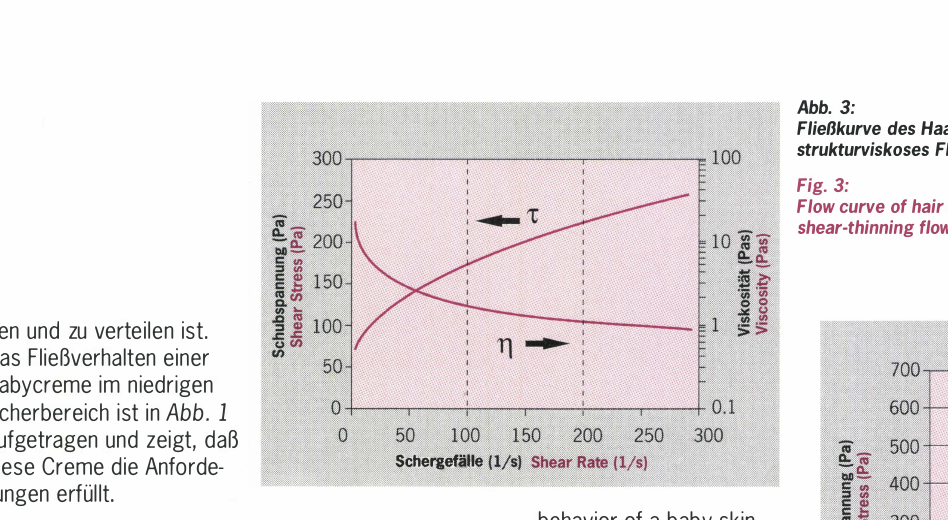
Fig. 3: Flow curve of hair gel, note the